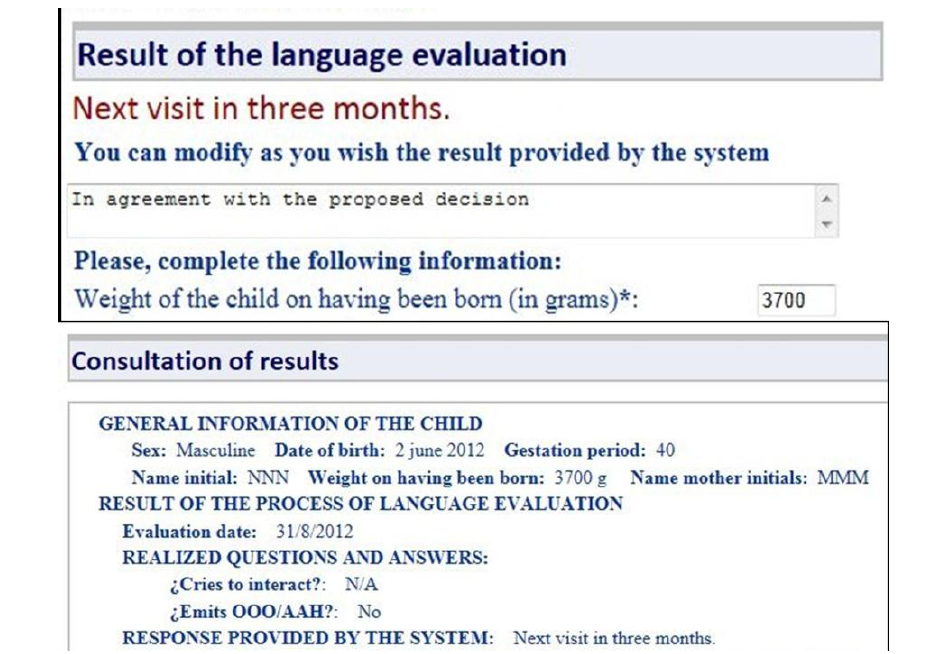
Figure 13. Query of results of language